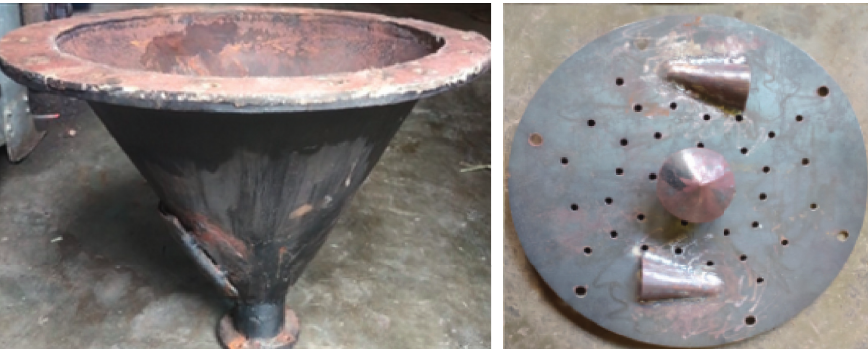
Figure 3: Modification of the perforated plate.